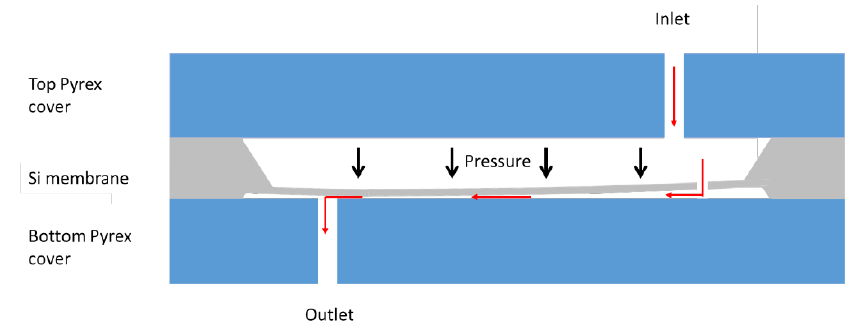
Figure 3. Schematic cross-section of a triple-stack passive flow regulator, with a Si wafer (membrane), bonded to the inlet and outlet Pyrex covers. The flow direction is indicated by red arrows. The fluid is forced to flow through the gap (or channel) between the membrane and the bottom cover that narrows as the pressure increases. As a result, the flow–pressure relationship becomes nonlinear.